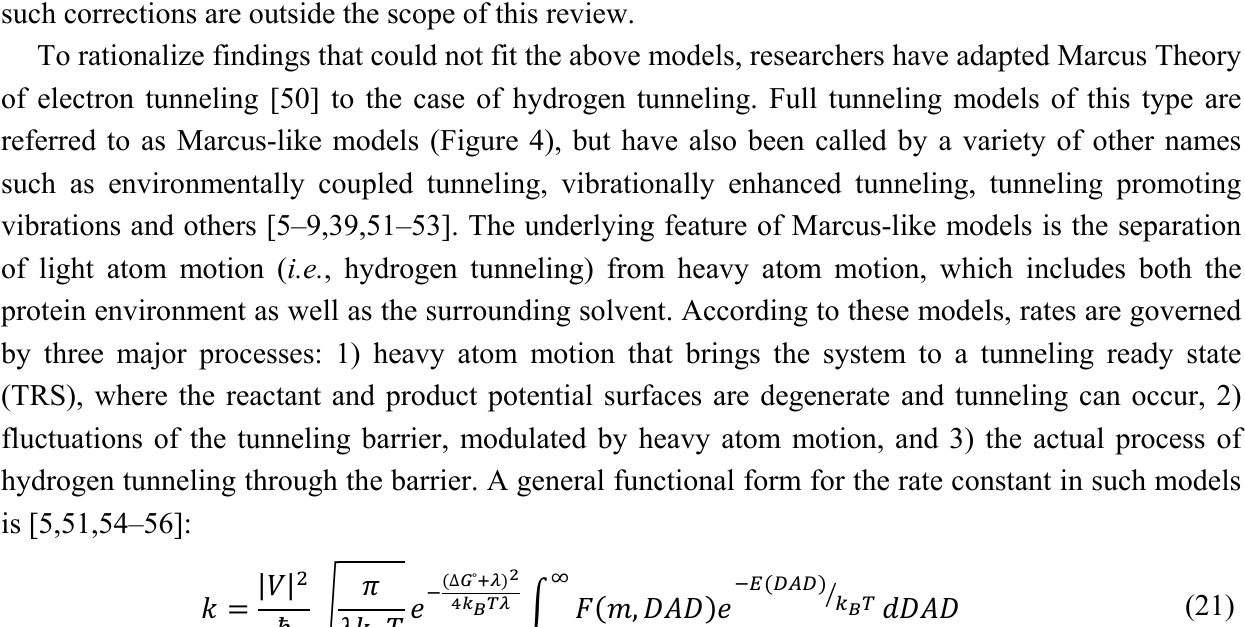
/A is much smaller than unity. Both isotopes tunnelin L H /A much higher than unity. Reproduced with permission L H